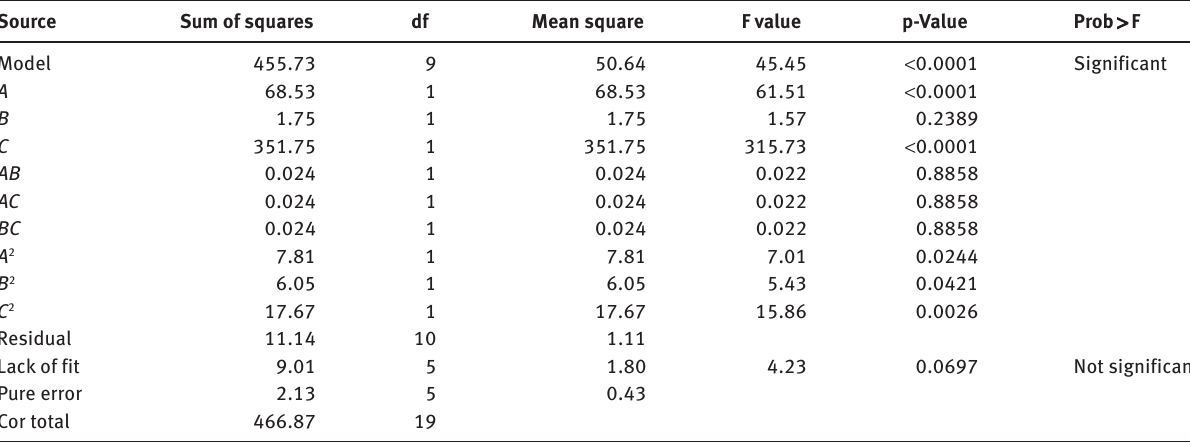
Table 3: ANOVA data of the response surface quadratic models for separation factor. Source Sum of squares